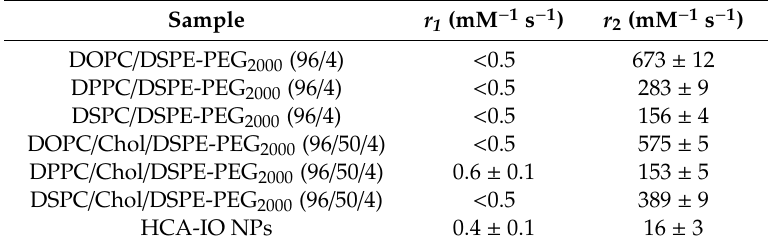
Table 3. MLs as a promising MRI T 2 contrast agent. Calculated longitudinal ( r 1 ) and transverse ( r 2 ) relaxivities of di ff erent MLs and HCA-IO